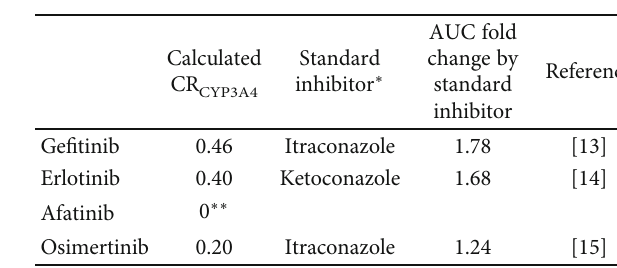
Figure 2: Microscopic features of lung cancer. (a) Adenocarcinoma cells from the fi rst biopsy of a mediastinal lymph node. (b) Small cell transformation from the second biopsy of the hilar lymph node (hematoxylin and eosin stain; original magni fi cations: (a) × 200; (b) × 400). (c – e) Immunohistochemistry of small cell carcinoma cells with neuroendocrine markers. Synaptophysin (c), CD56 (d), and chromogranin A (e) (c – e, × 400). Table 1: Contribution ratio of CYP3A4 to clearance of EGFR-TKIs after oral absorption (CR CYP3A4